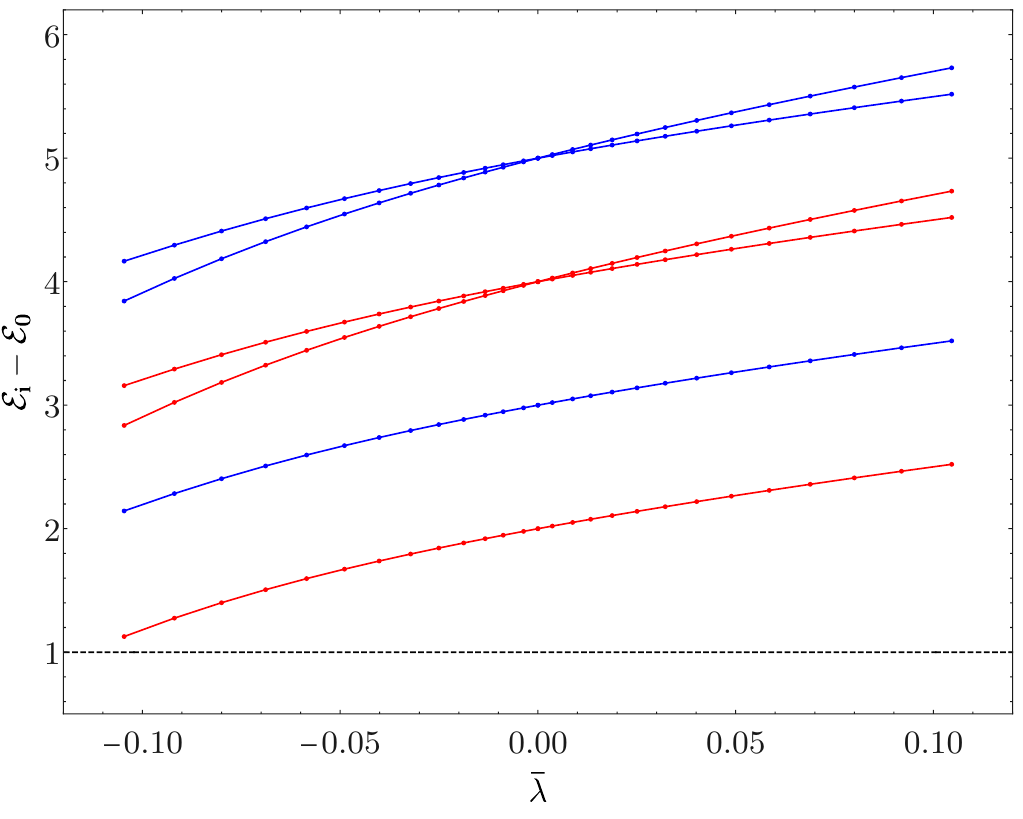
Figure 32. Spectrum of the Ising model in a magnetic field, as a function of the magnitude of the field. Error bars as measured from the uncertainty in the extrapolation are not shown: they would be small, throughout the plot, but as discussed in the text they probably underestimate the deviation from the continuum